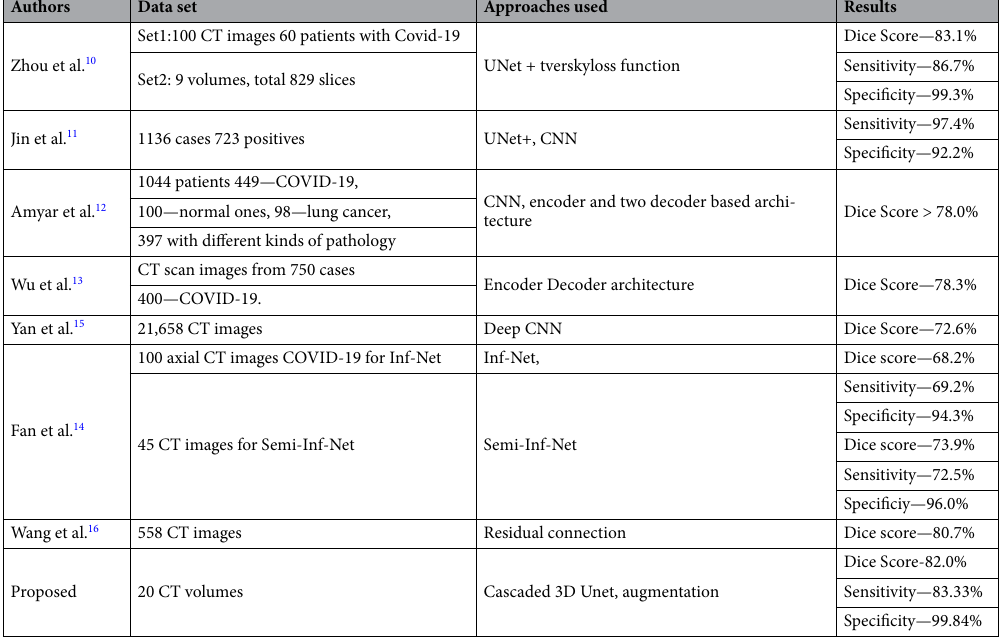
Table 4. Comparison of the proposed method with current literature